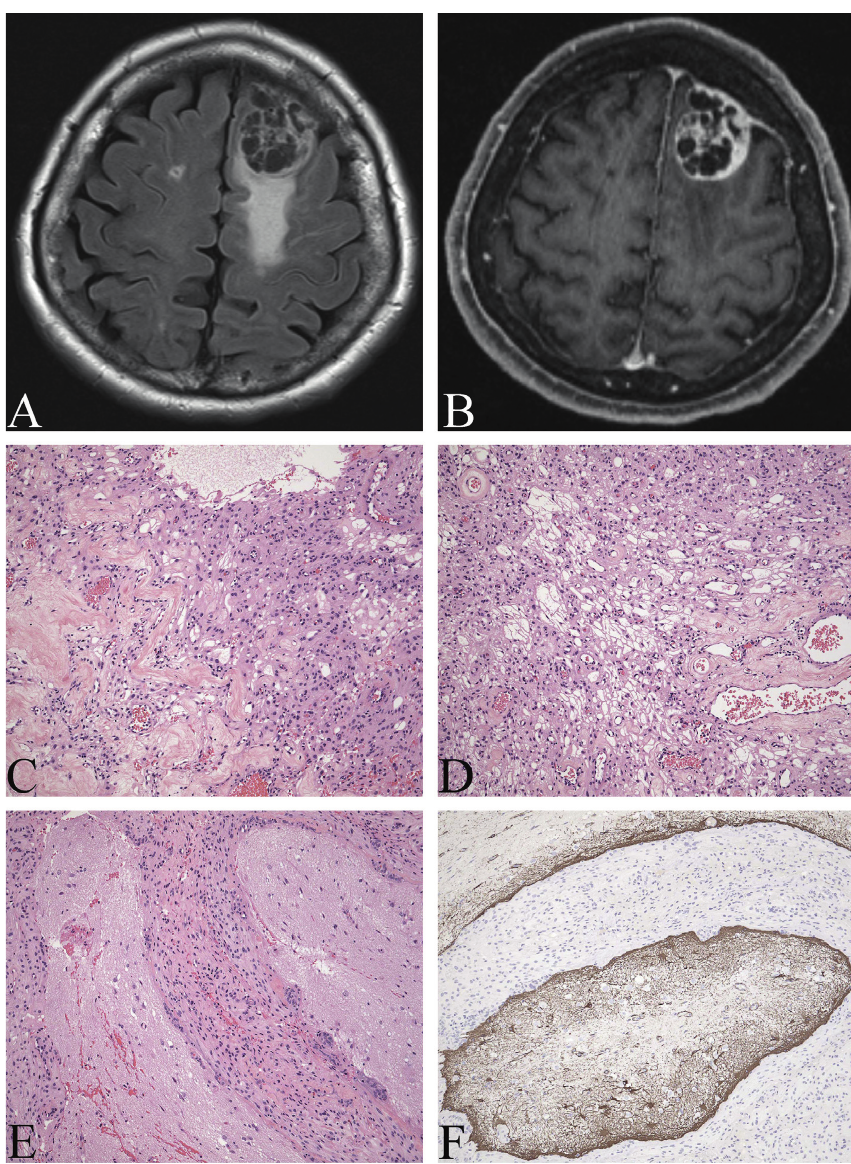
Figure 1: FLAIR (a) and T1 postcontrast (b) MRI images showing dural-based enhancing (b) lesion with associated FLAIR hyperintensity (a). Histology shows angiomatous (c), microcystic (d), and histology with brain invasion (e) as highlighted by GFAP (glial fibrillary acidic protein) immunostain (f). Original magnification (c)–(f):